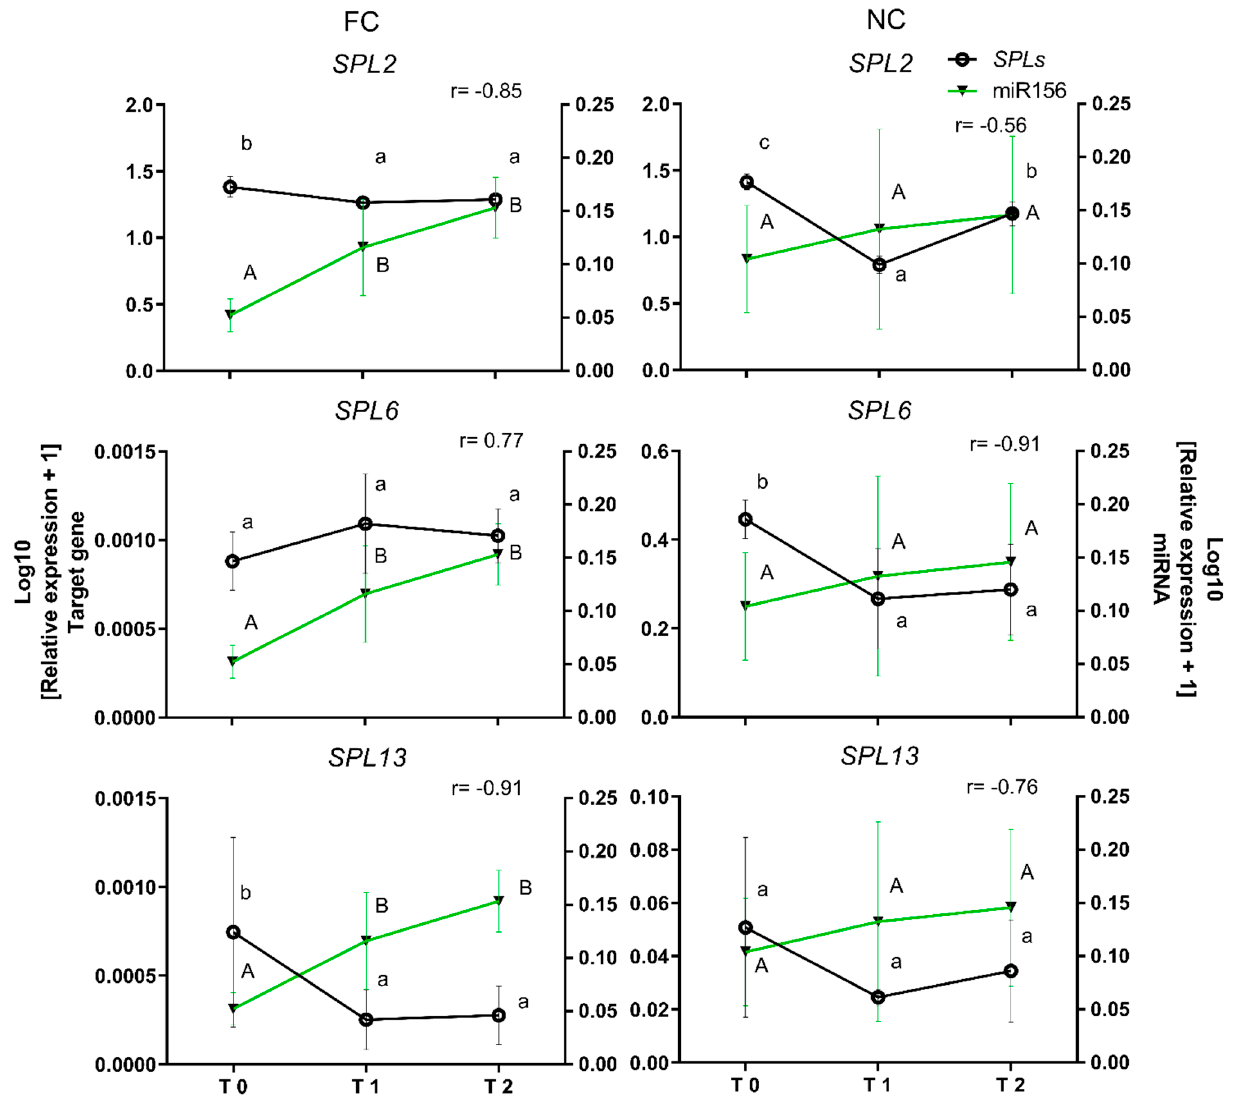
Figure 6. Comparison of miR156 relative expression and its predicted SPL target genes under field chilling (FC) and non-stop chilling (NC) conditions. Floral buds were obtained from trees subjected to natural cold accumulation in the field (FC) and from sticks subjected to continuous chilling under cold storage (NC) conditions. Expression levels of SPL genes and miR156 were determined by qRT-PCR in both experimental conditions. Means with different letters among stages are significantly different ( p ≤ 0.05). The gene expression levels in FC and NC conditions were compared with miR156 expression levels. Pearson correlation (r) was determined between the relative expression of the SPL gene miR156 in both seasons. Black line, relative expression SPL genes. Green line, relative expression of